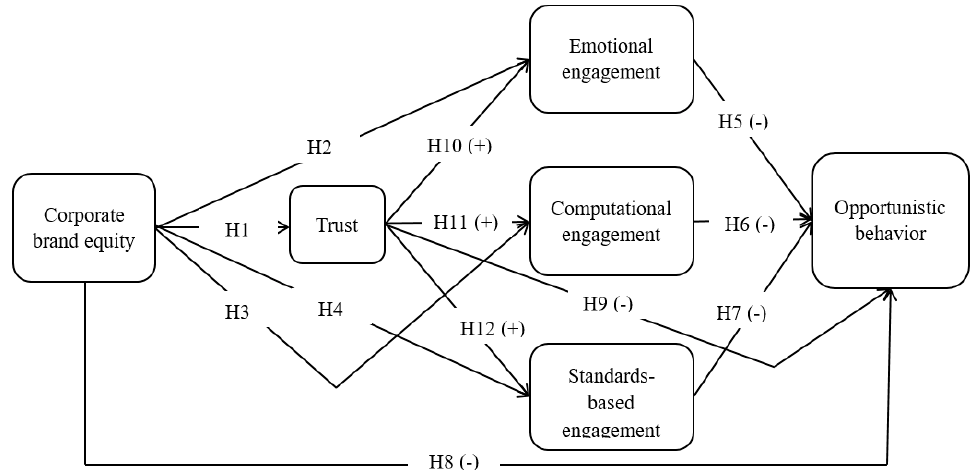
Figure 1. Research